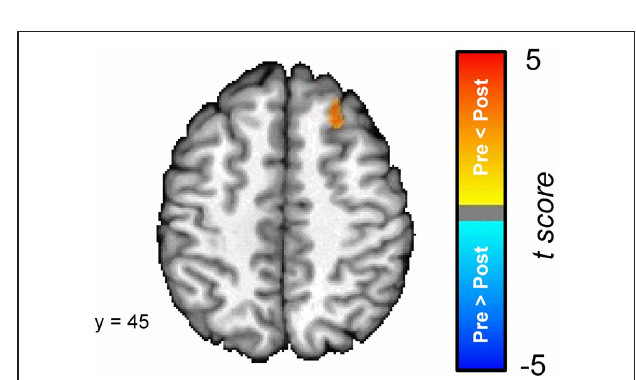
FIGURE 5 | The dorsal medial prefrontal cortex (superior frontal gyrus) [Talairach coordinates: 24, 30, 45] shows a significant increase in its connectivity with the amygdala following the conditioning task. The colors on the brain map correspond to the t -values on the color